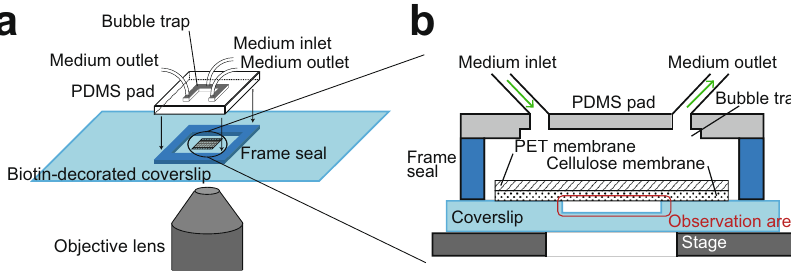
Fig. 1 Sketch of the extensive microperfusion system (EMPS). a Entire view of the device. Microwells are created on a glass coverslip. We attach a polydimethylsiloxane (PDMS) pad on the coverslip with a square frame seal to fi ll the system with liquid medium. b Cross-sectional view inside the PDMS pad. A polyethylene terephthalate (PET) – cellulose bilayer porous membrane is attached via the biotin – streptavidin bonding. Note that there are two outlets as in ( a